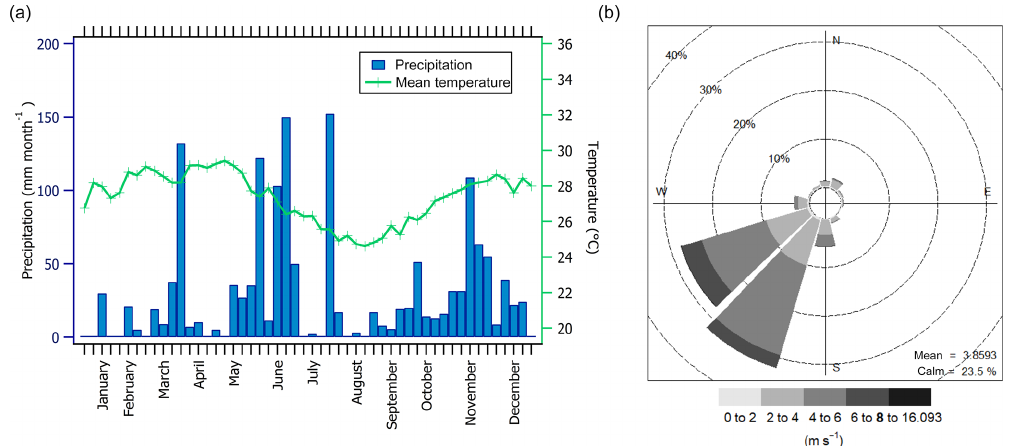
Figure 2. Meteorological data observed in Abidjan, Côte d’Ivoire. The figure represents (a) the weekly accumulated precipitation (in mmmonth − 1 ) and weekly mean air temperature (in ◦ C) and (b) the wind speed (in ms − 1 ) and direction observed (deg), during the field campaigns (2016). Data were downloaded from the National Centers for environmental information site (NCDC), NOAA, and recorded at Abidjan International Airport (see location in Fig. 1).